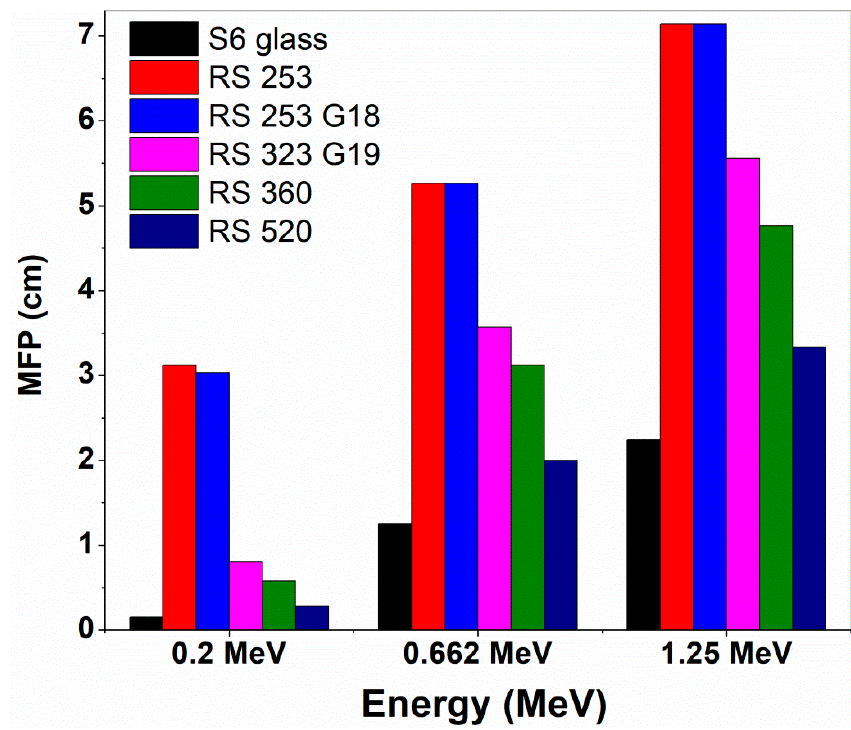
Figure 3. Comparison of MFP of the glass ‘S6 ′ with some commercial glasses.